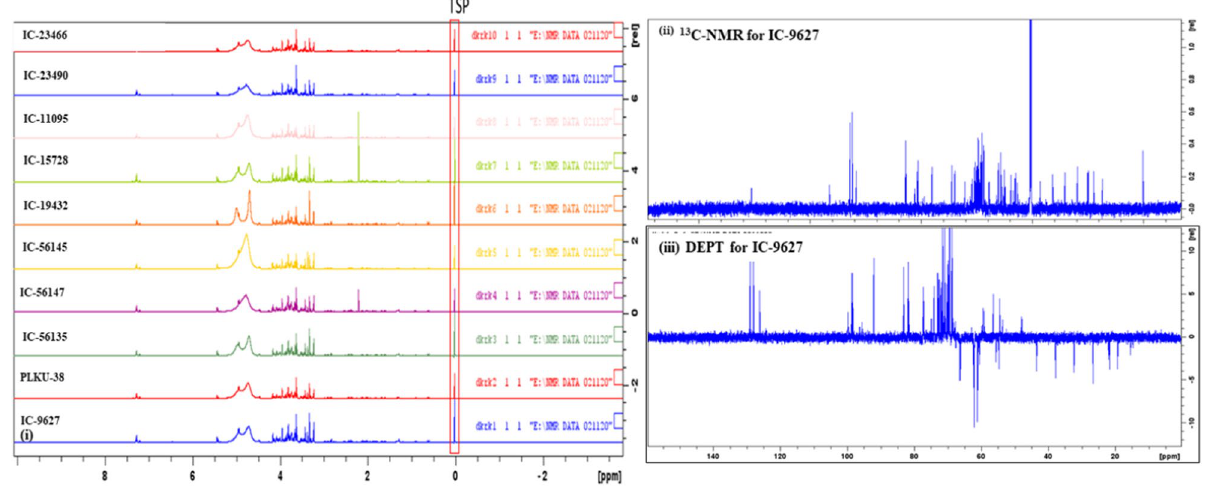
Figure 1. ( i ) Nuclear magnetic resonance spectral of ten representative lines of diverse panel of horsegram germplasm ( ii ) 13 C NMR spectra and ( iii ) Distortions Enhancement by Polarization Transfer (DEPT) spectrum for distinguishing between CH 3 group, CH 2 group and CH